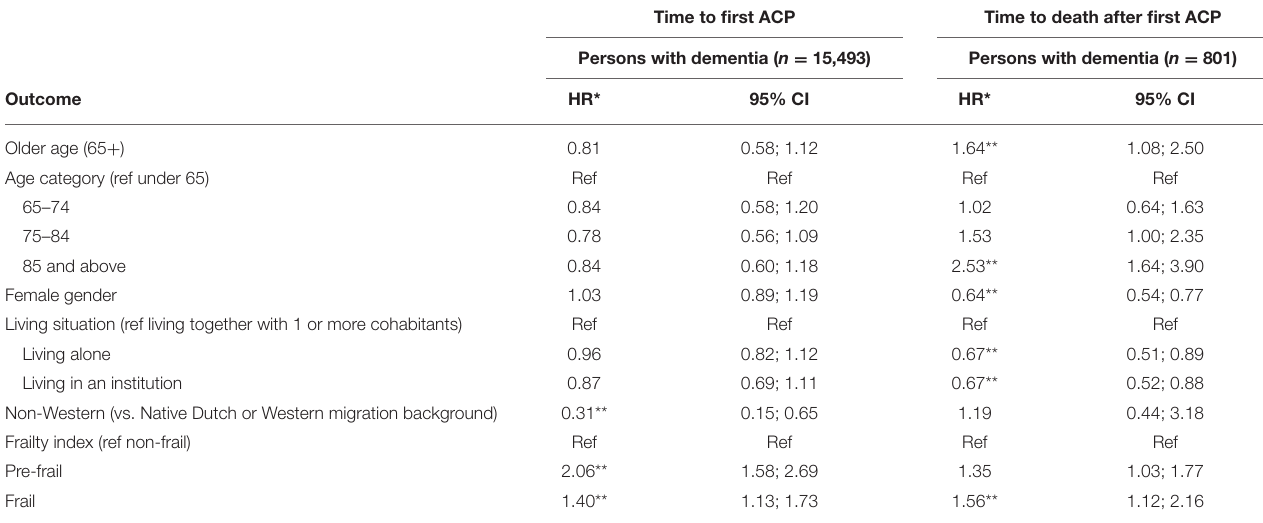
TABLE 4 | Results of competing risk regression examining characteristics associated with time from diagnosis to a first ACP conversation, and results of Cox proportional hazard regression examining characteristics associated with time from a first ACP conversation after diagnosis to death in persons with